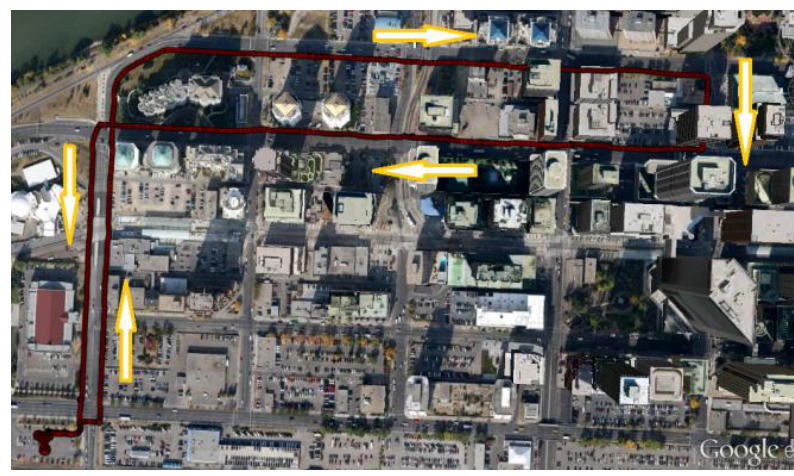
Figure 5. Reference trajectory (urban canyon).